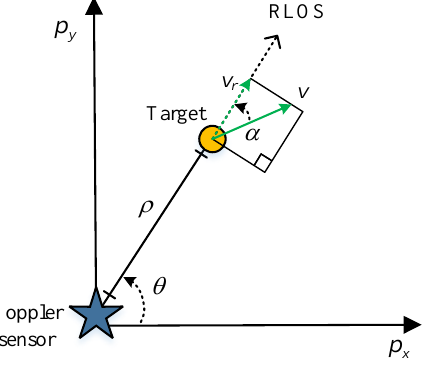
Figure 2. Definition of radial